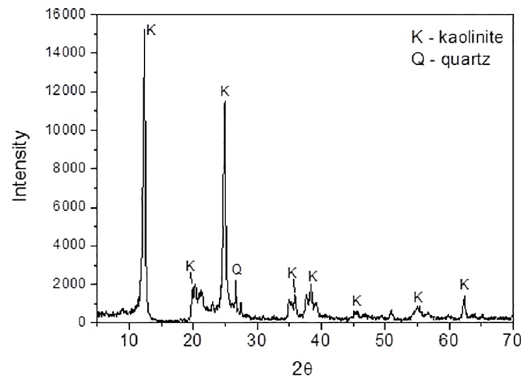
Figure 2. XRD pattern of raw kaolin.